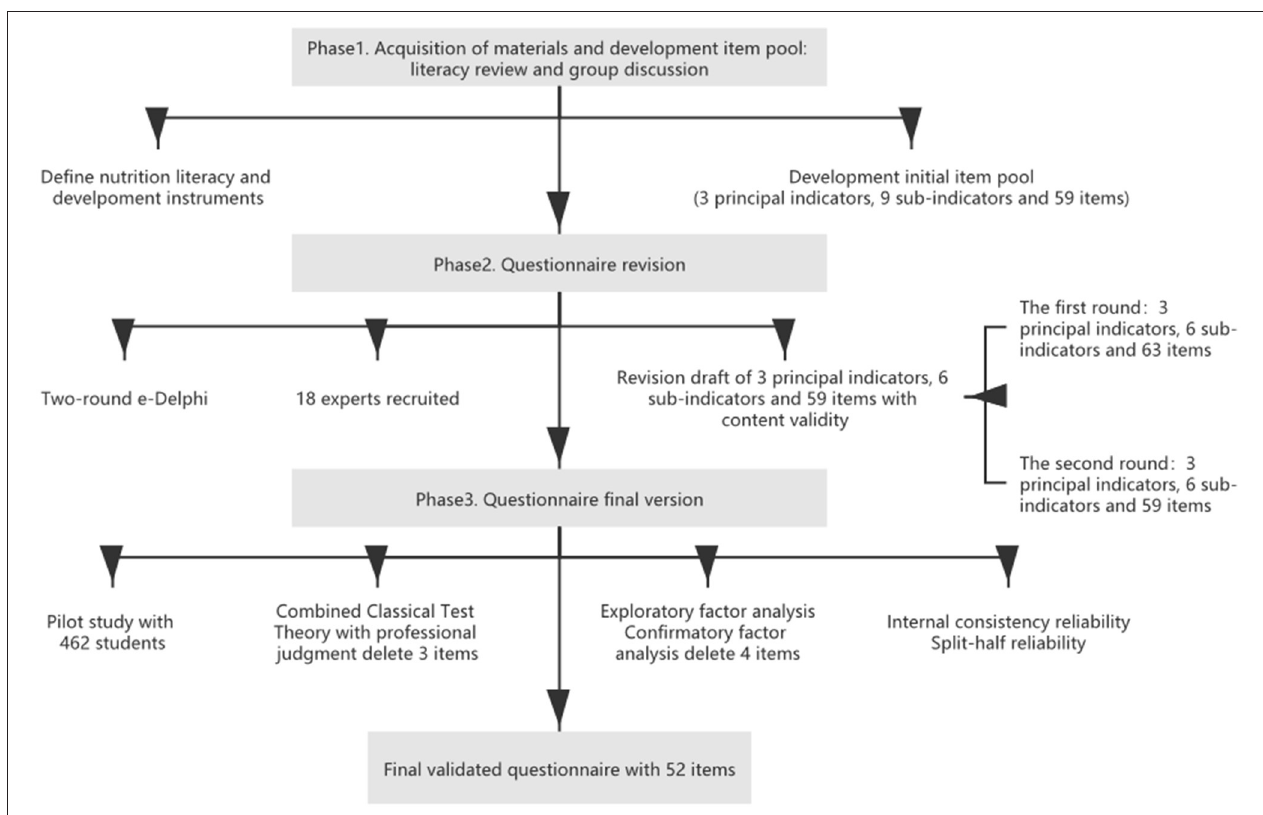
FIGURE 1 | Flow chart of the questionnaire development procedure.